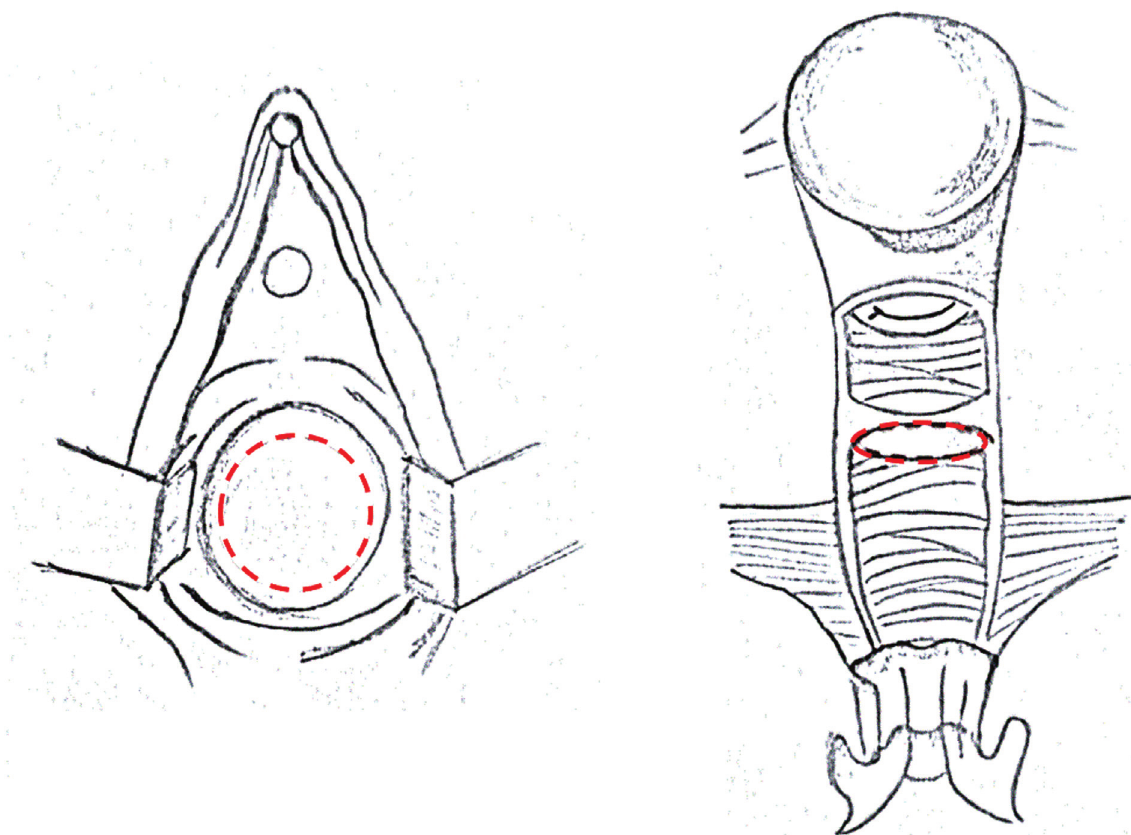
Fig. 2 Drawings of the hysteroscopic resection: the red circle indicates the endoscopic incision line.